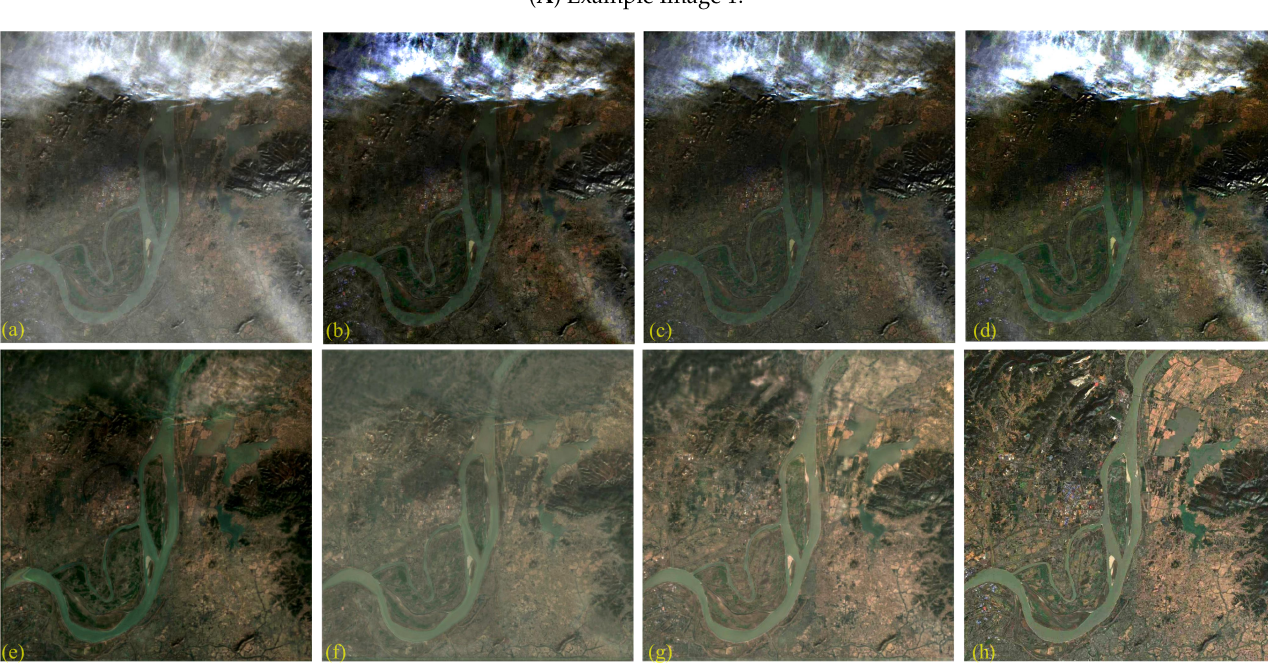
Figure 11. Dehazing results on images with heavy haze interference. ( a ) Hazy image; ( b ) DCP; ( c ) DehazeNet; ( d ) AOD-NET; ( e ) GridDehazeNet; ( f ) MSBDN; ( g ) proposed method; ( h ) haze- free